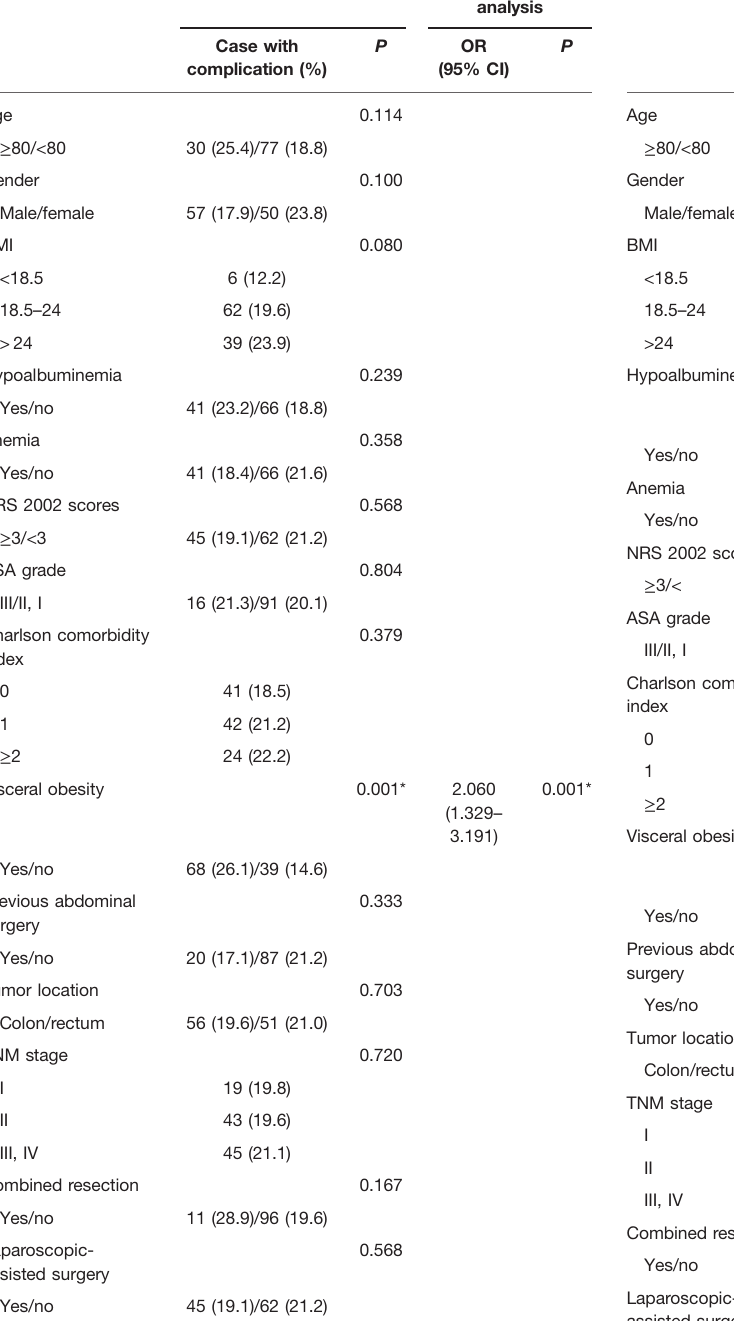
TABLE 4 | Univariate and multivariate logistic regression analysis of risk factors for surgical complications. Factors